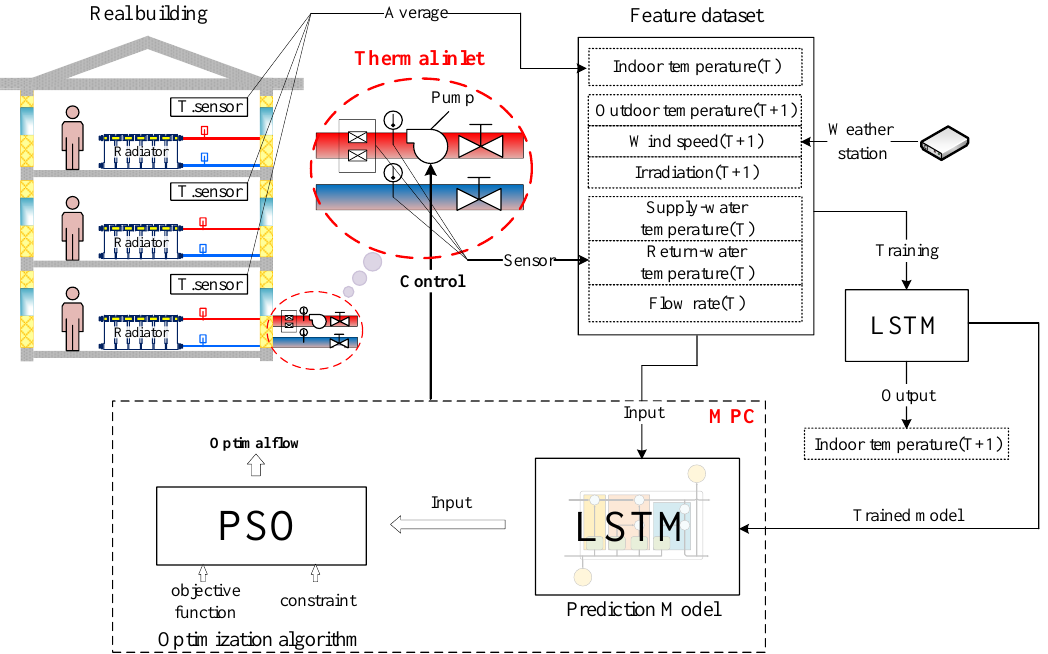
Figure 2. Principal structure of the control and adjustment